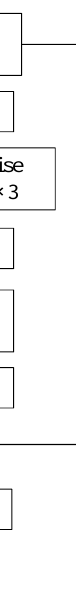
Figure 12. Bottleneck after embedding